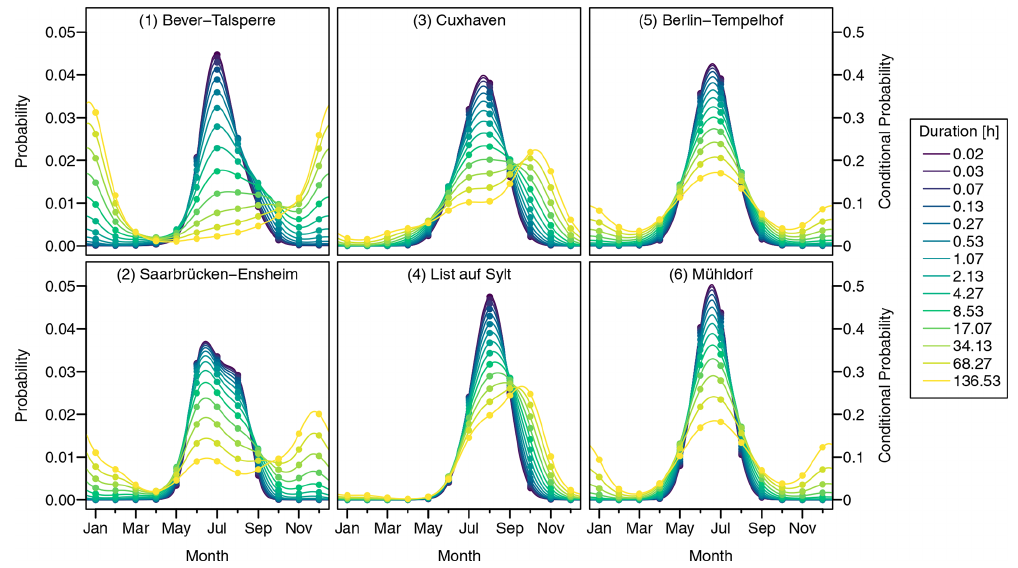
Figure 4. Probability of the annual 0.9 quantile q 0 . 9 , d being exceeded in a given month. Dots indicate the probability that q 0 . 9 , d is exceeded in a certain month, while each point in a line can be interpreted as the probability that q 0 . 9 , d is exceeded within the surrounding block of 30d. To illustrate the interpretation, the product of all probability values presented as dots for a chosen duration results in the annual exceedance probability 1 − p = 0 . 1. Therefore, dividing the probability values by 0.1 yields the conditional probability of exceeding q 0 . 9 , d in a given month. For reasons of visual clarity, confidence intervals are not presented. Station names are listed at the top of each plot, while the numbers indicate their positions in Fig.